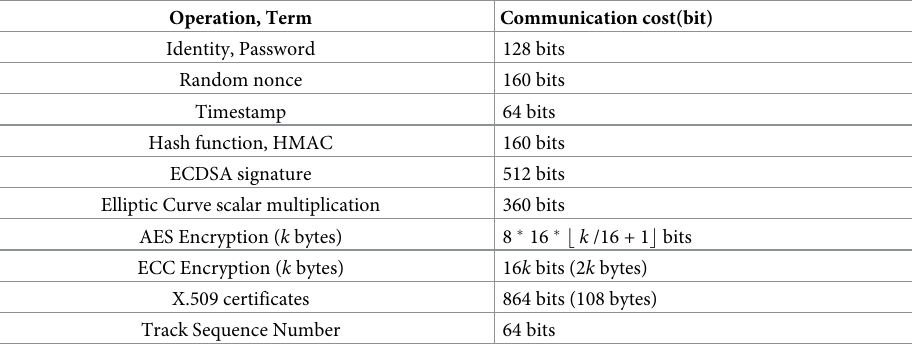
Table 5. Communication cost(bit) of each